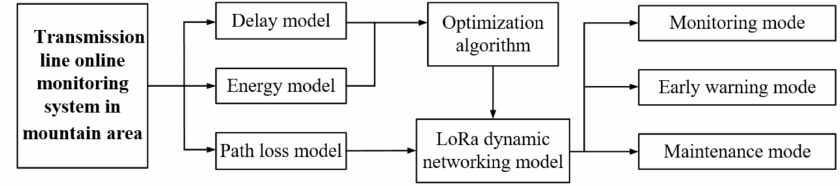
Figure 1. Design of the system monitoring scheme in a mountainous area.